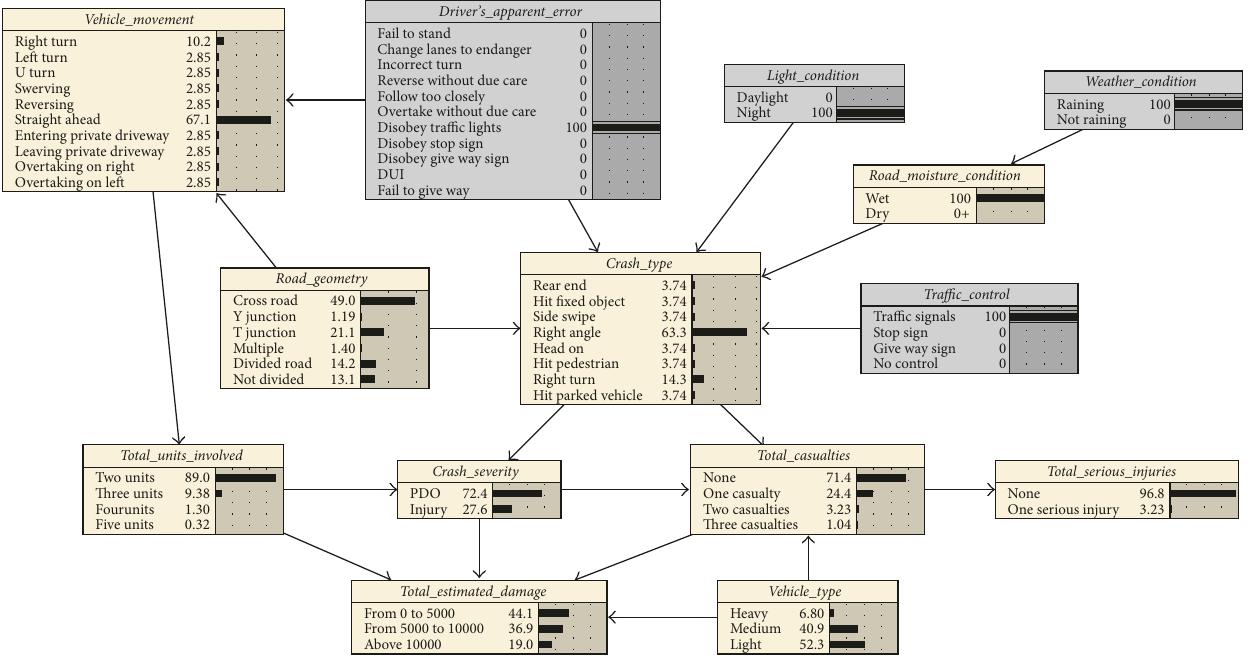
Figure 10: Road accident prediction when the evidence variables are “traffic signals,” “disobey traffic lights,” “night,” and “raining.”